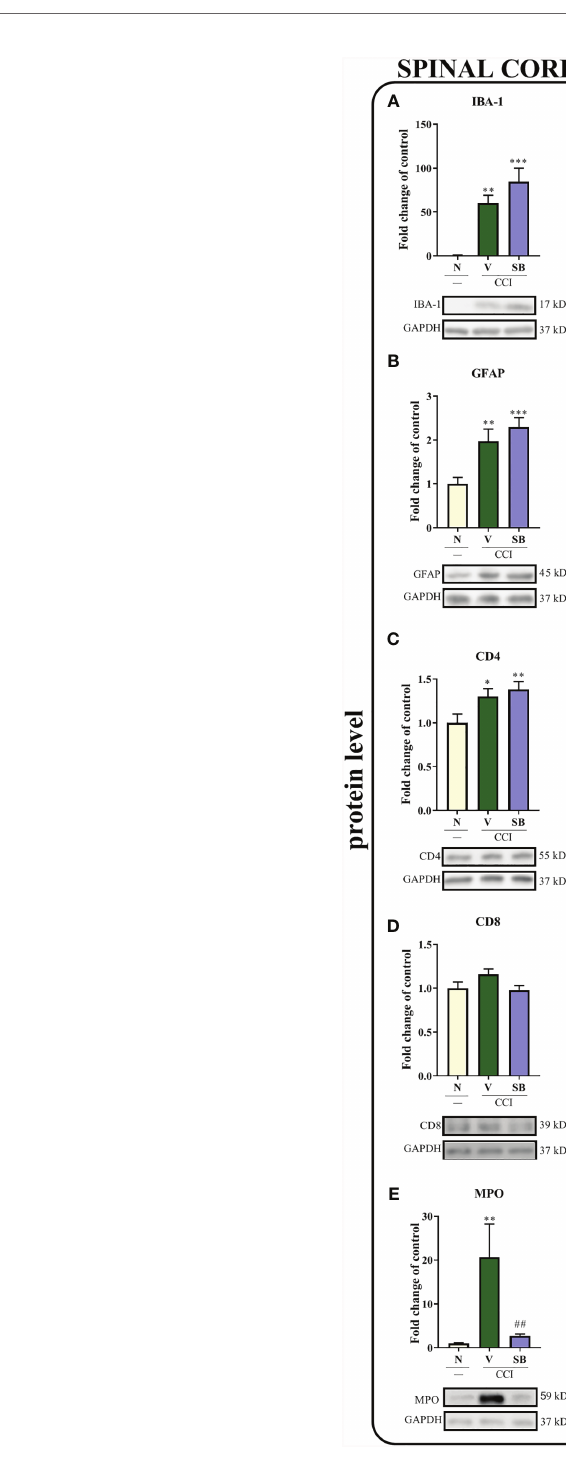
FIGURE 8 | Effects of repeated administration of SB328437 (SB, 10 m g/5 m l; i.t .) 16 h and 1 h before chronic constriction injury of the sciatic nerve (CCI) and then once a day for 7 days on levels of the IBA-1 (A, F) , GFAP (B, G) , CD4 (C, H) , CD8 (D, I) and MPO (E, J) proteins in the rat spinal cord (A – E) and the DRG (F – J) on the 7 th day post- CCI. The data are presented as the mean fold changes relative to the control ± SEM (6 – 8 samples per group). Intergroup differences were analyzed using ANOVA with Bonferroni ’ s post hoc test for multiple comparisons. *P < 0.05, **P < 0.01, and ***P < 0.001 indicate signi fi cant differences compared with the control group (naive, N rats); # P < 0.05 and ## P < 0.001 indicate signi fi cant differences compared with the Vehicle (V)-treated